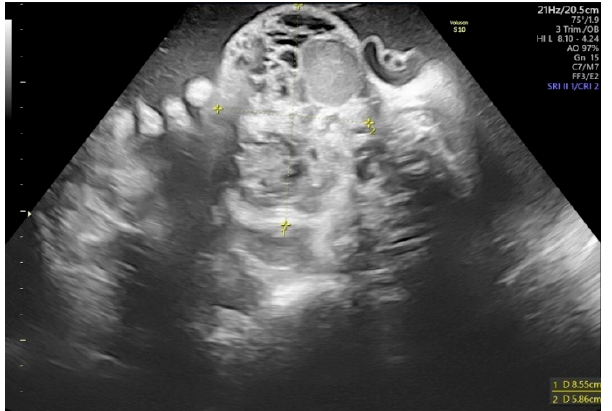
Figure 1. A longitudinal scan of the malformation on the 29th week of gestation. The lesion forced a retroflexed position of the fetal head.